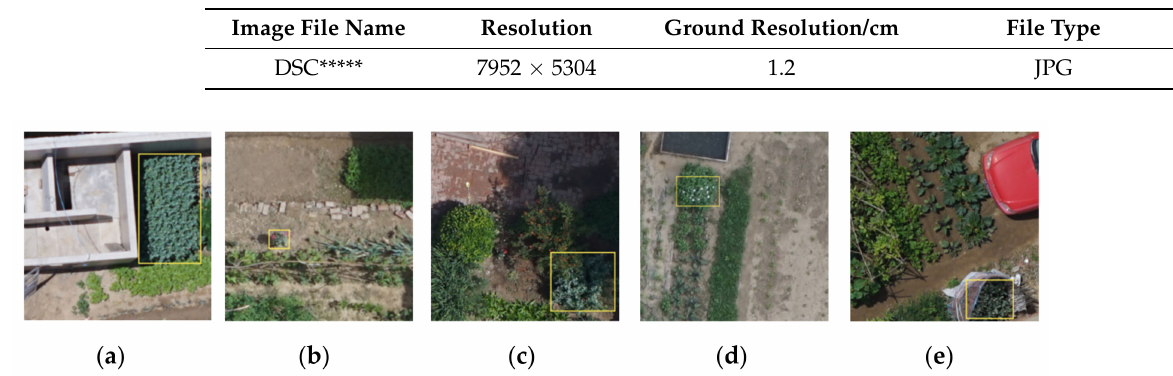
Figure 2. Small-area poppy cultivation strategies. ( a ) Concentrated planting; ( b ) single-plant planting; ( c ) shadow planting; ( d ) mixed planting; ( e ) covered